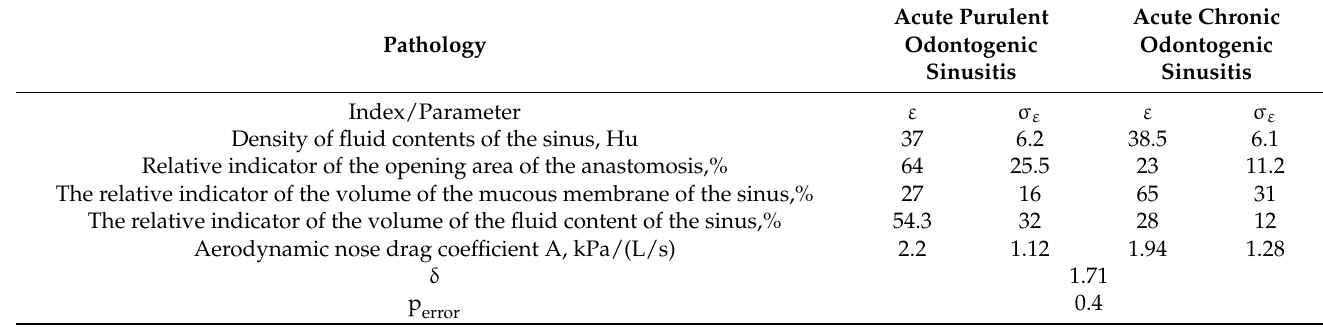
Table 5. Main indicators and results of differential diagnosis of forms of acute purulent and exacerbated chronic odontogenic sinusitis.